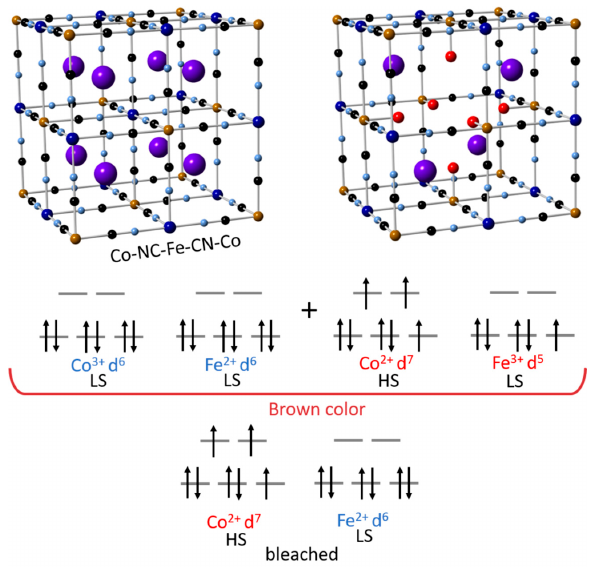
Figure 2. Schematic view of the CoHCF crystal structure and expected valence / spin states for the respective redox state (ICSD no. 157486). Illustration based from [43,44].